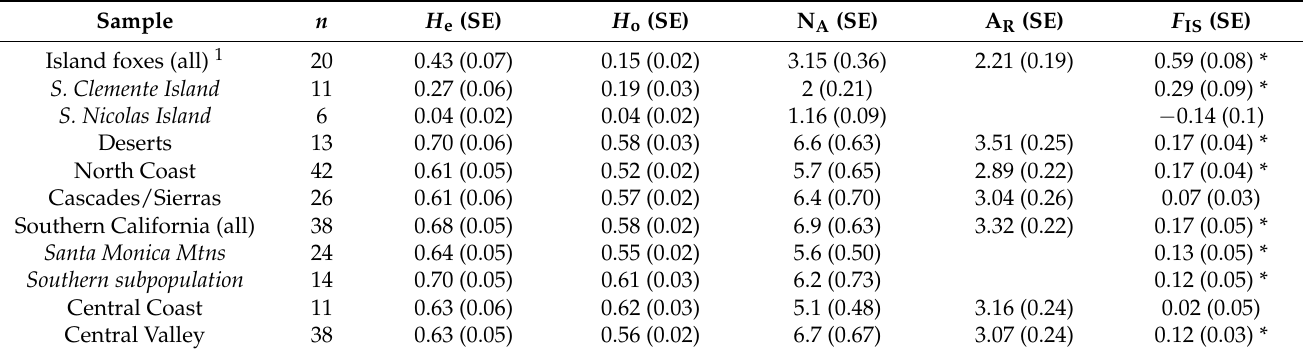
Table 1. Population genetic statistics based on 20 microsatellite loci for 188 island foxes ( Urocyon littoralis ) and western gray foxes ( U. cinereoargenteus ) from 4 islands and 5 mainland sampling locations in western North America, including expected heterozygosity ( H e ; under Hardy–Weinberg expectations), observed heterozygosity ( H o ), average numbers of alleles per locus (N A ), allelic richness (A R ), and inbreeding coefficient ( F IS